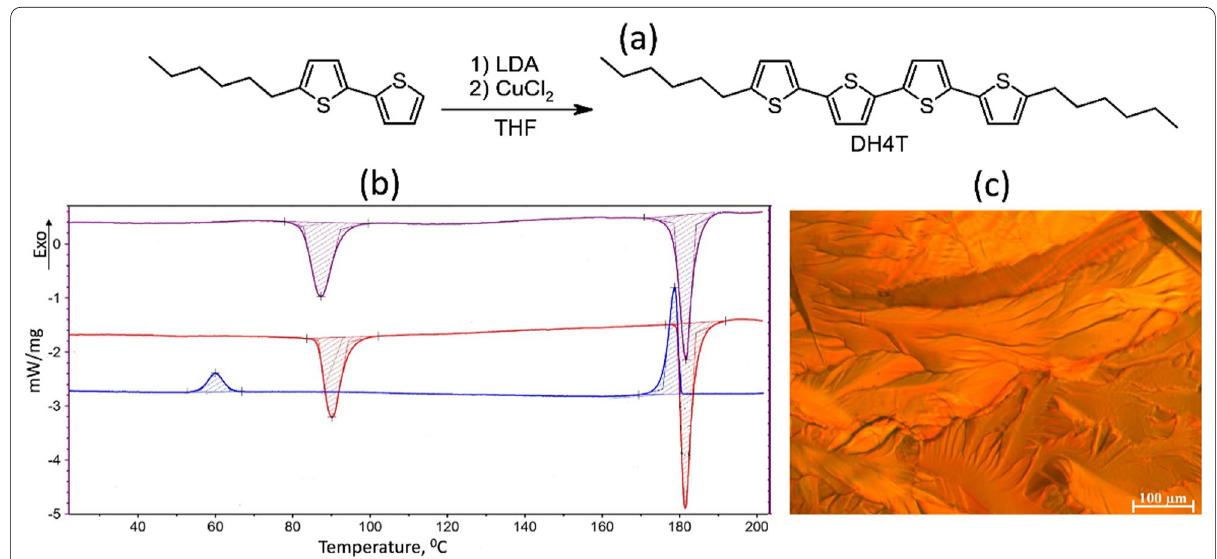
Fig. 2 a Synthesis of DH4T; b heating–cooling–heating DSC cycle of DH4T; c polarized-light microscopy image of the DH4T